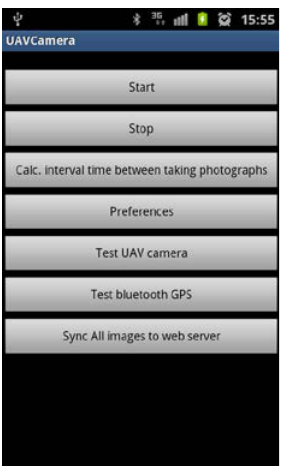
Figure 3. Screen for the implemented UAV photography system